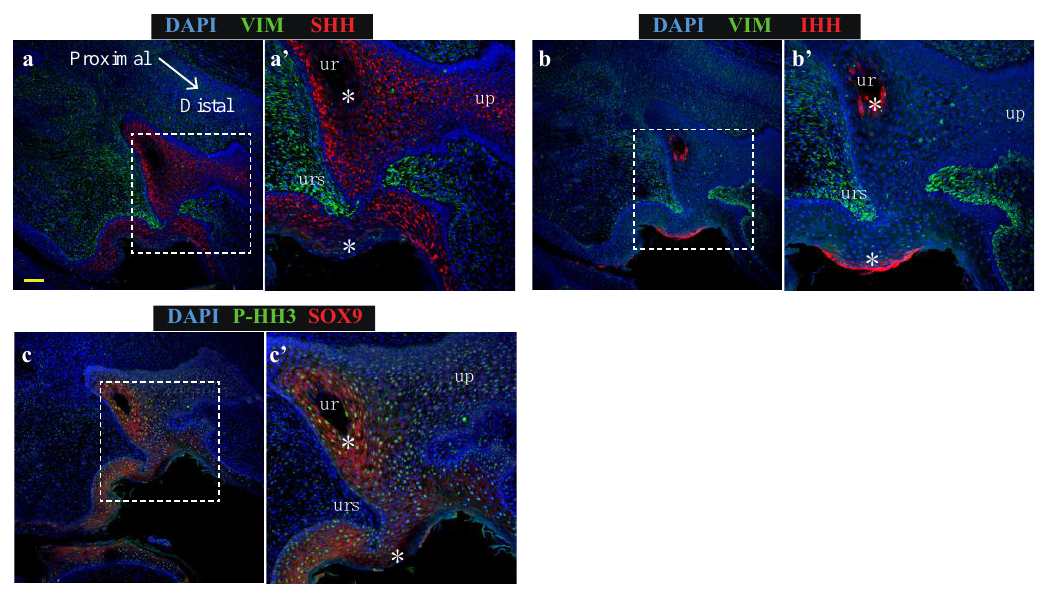
Figure 4. SHH and SOX9 expression is low in urethral epithelial and phallic skin cells expressing IHH ( a ) Expression of SHH (red) and vimentin (green), ( b ) Expression of IHH (red) and vimentin (green) or ( c ) Expression of SOX9 (red) and proliferation marker, P-HH3 (green) in oblique sections of day 60 wallaby phallus tissue. (ur = urethra; up = urethral plate epithelium) Scale = 100μm.